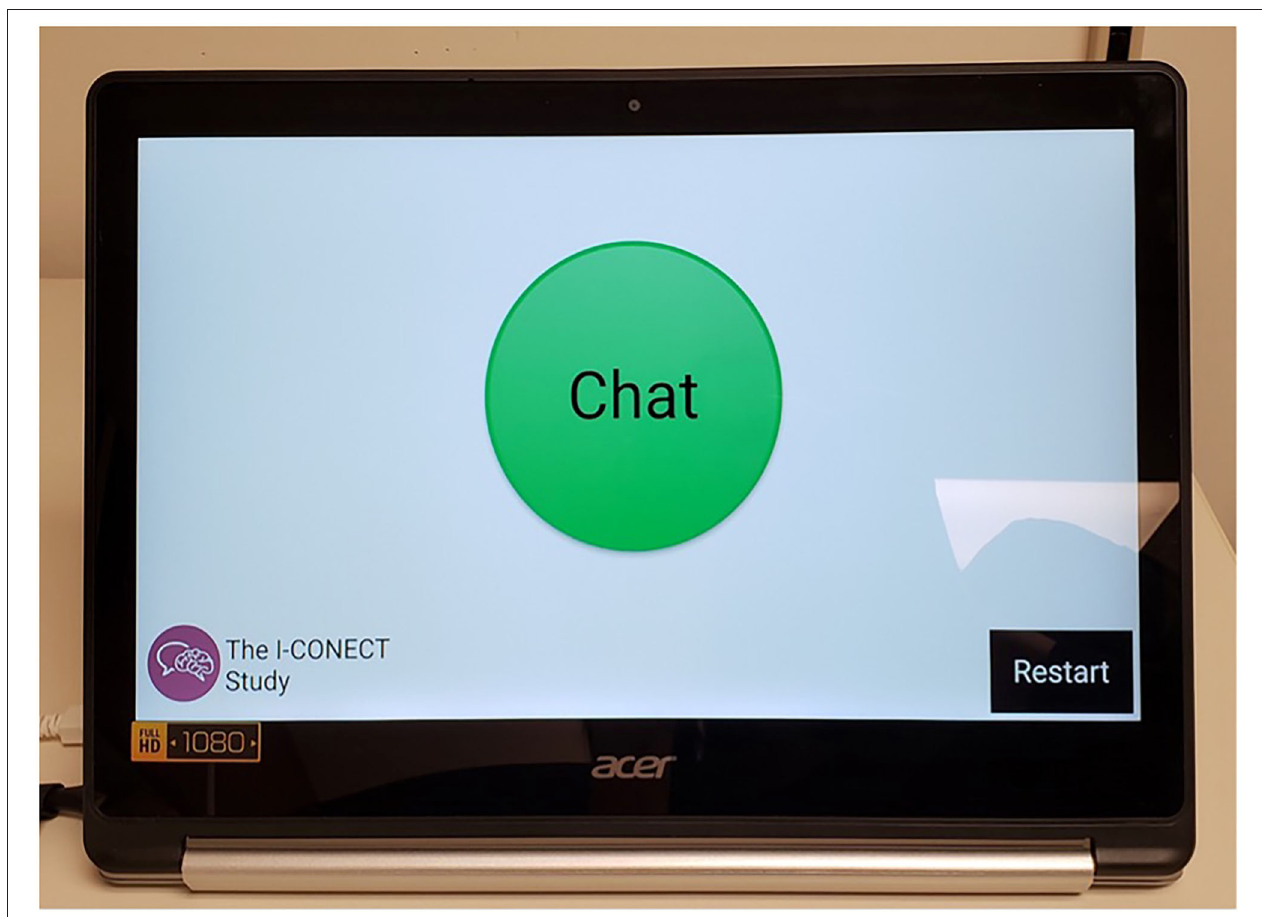
FIGURE 2 | The screen seen by the participant before video chats. We use an entry level 2-in-1 Chromebook with device being managed through Google’s G Suite Enterprise for Education for video chats. When calls are coming in, participants touch the green bottom in the middle of the screen to start the video chats. A restart button was placed highly visibly which is important when malfunctions occur and restarting is needed. All video and audio are recorded for analyses with participants’ consent (33,